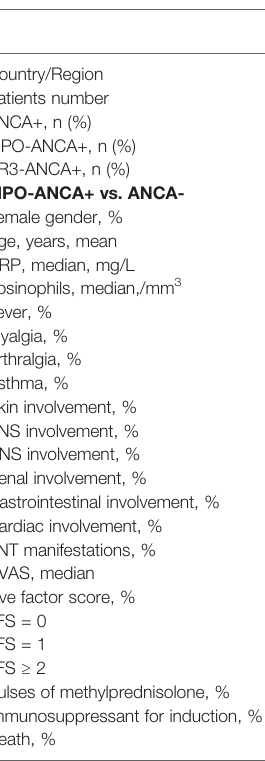
TABLE 3 | Comparison of EGPA cohorts from different